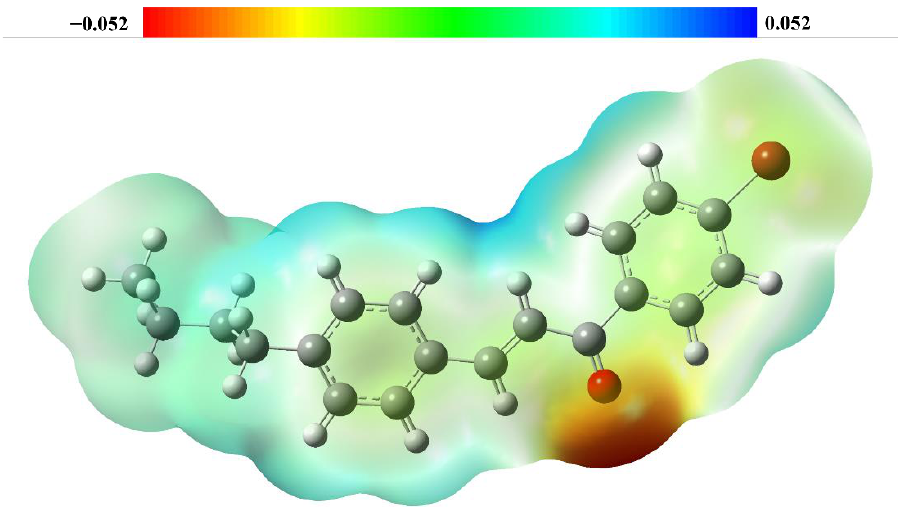
Figure 14. Molecular electrostatic potential map of BBP. The red region is rich in electrons, and the blue is electron depleted.